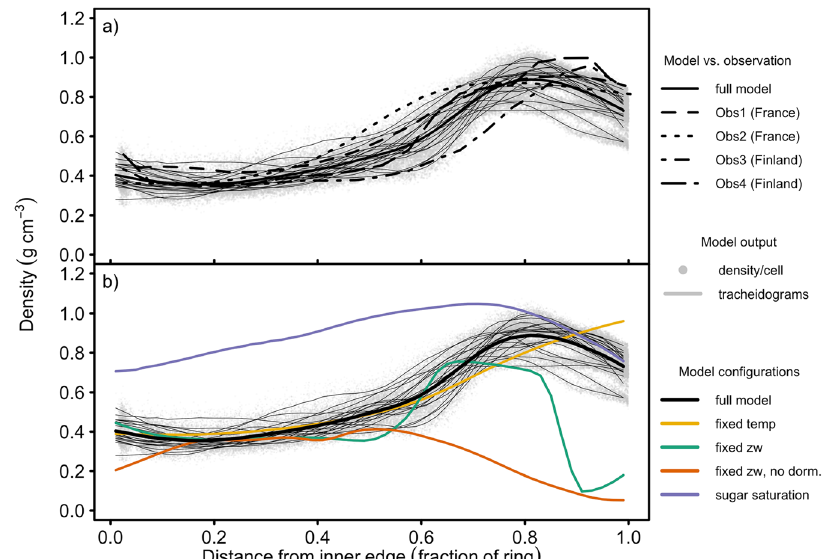
Fig. 2 | Simulated cell-mass densities (i.e.cell mass/volume) across normalised ring width of Pinus sylvestris L. at 64.25°N, 19.75°E (northern Sweden), 1976 – 1995. Simulations used a spin-up over 1951 – 1975, with proliferating cells carried over between years. Light grey solid lines are annual mean pro fi les of simulated cell-mass density standardised across 100 independent radial fi les per simulation. Wider solid lines (representing different model con fi gurations) are the mean of all annual cell-mass density pro fi les (light grey lines in the case of the default simulation) across the entire simulation period. The mean pro fi les were calculated by binning cells in 0.02-fraction-wide bins and then computing the